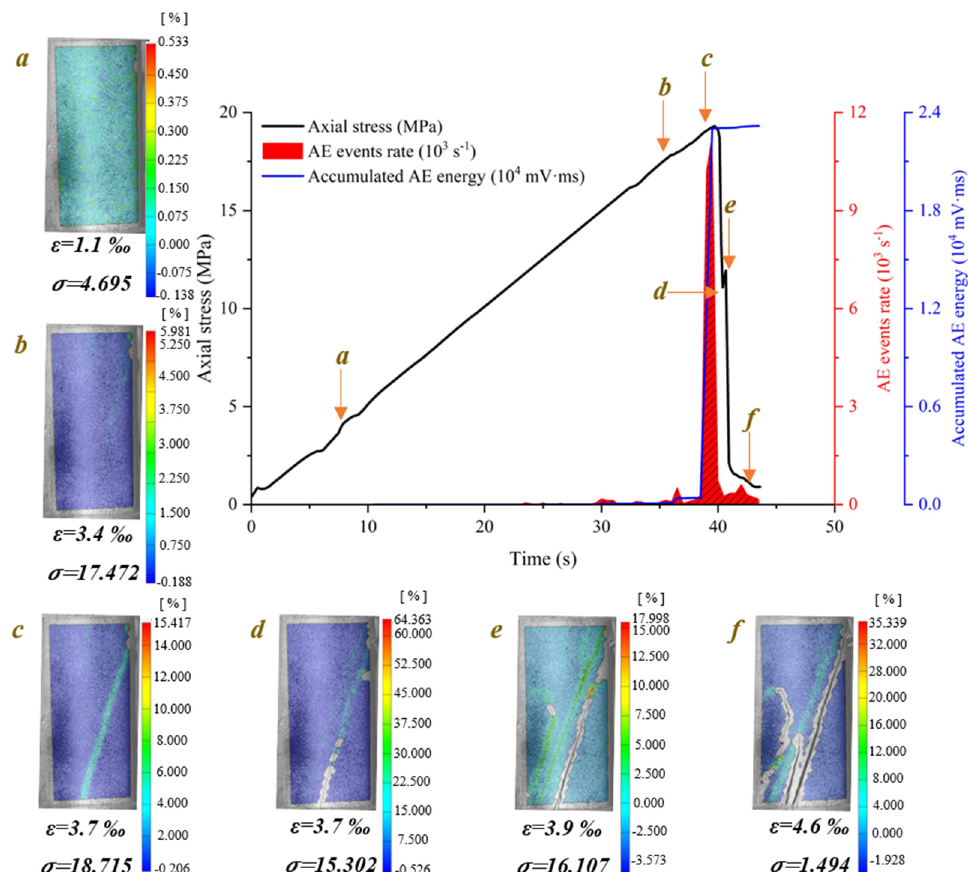
Figure 8. Crack evolution process of water-saturated phyllite with 60° foliation angle (S-W-60°).